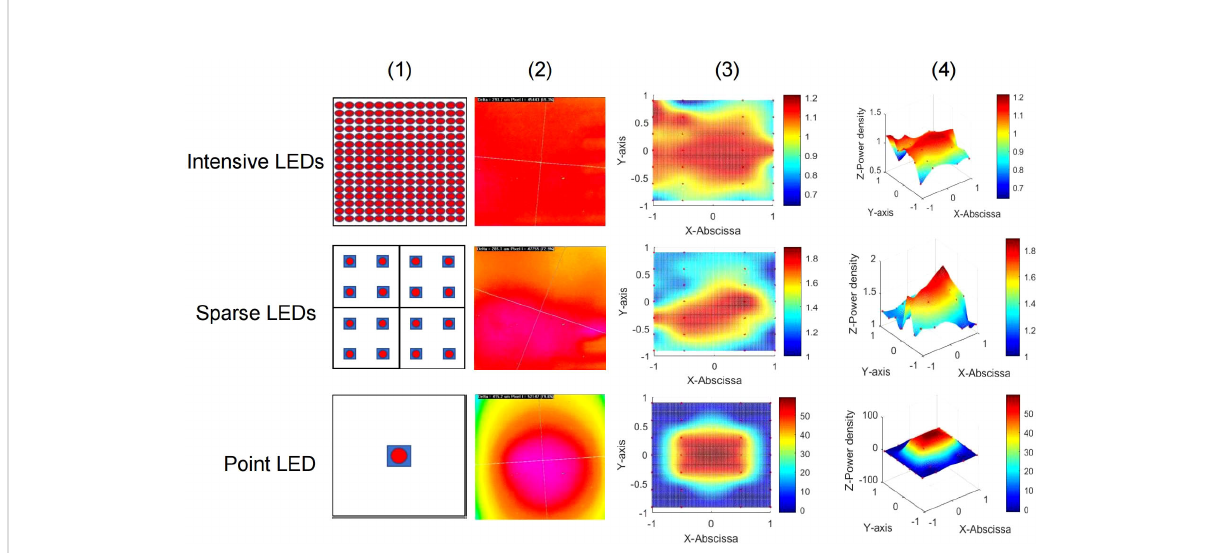
FIGURE 1 Three LED arrays with different light fi elds for in vitro experiments. Top: Intensive LED array producing a uniform light fi eld. Middle: Sparse LED array producing a non-uniform light fi eld. Bottom: Point LED array producing a Gaussian-like light fi eld. Performance of the three LED arrays: (1) Schematic diagram, (2) light spot, (3) two-dimensional heat map of power density distribution, and (4) three-dimensional heat map of power density